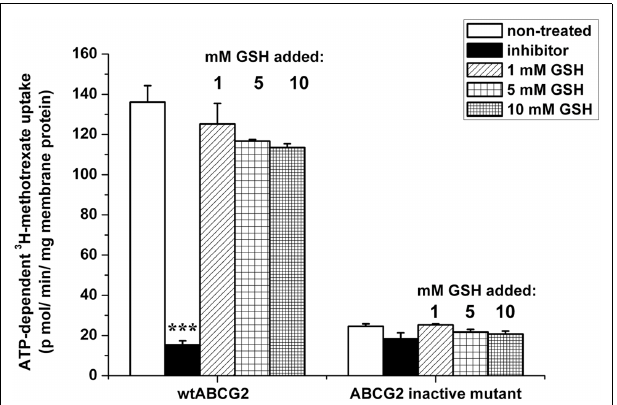
FIGURE 6 | Effect of GSH on the transport of methotrexate byABCG2. ATP-dependent transport of 3 H-methotrexate in 2 mM cholesterol-loaded insect-cell membranes expressing ABCG2 (either wild-type or the inactive K86M mutant) was measured for 10 min at 37 ◦ C.Transport was determined in the absence or presence of an ABCG2-specific inhibitor (1 μ M Ko143) or 1–10 mM GSH. Bars represent the average ± SD values of at least two measurements. t -test analysis: *** p < 0.001.